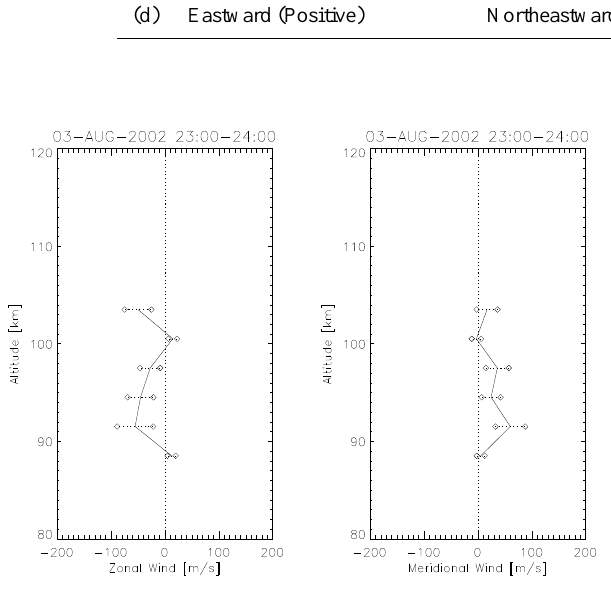
Zonal (Eastward) and Meridional (Northward) compo- nents of neutral wind velocity from 2300, 3 August, to 0100, 4 Au- gust 2002 are shown.